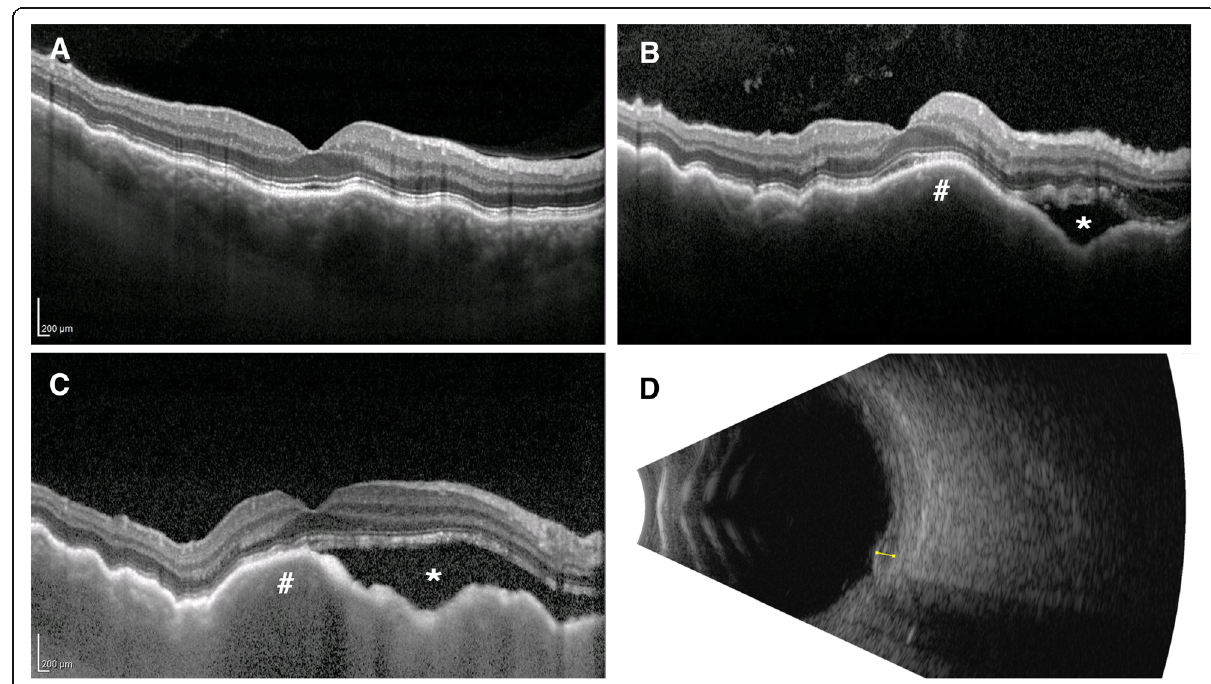
Fig. 1 EDI-OCT of patient prior to treatment initiation. a ) EDI-OCT at initial diagnosis of choroid folds; b ) EDI-OCT following worsening of symptoms 11 months later; c ) EDI-OCT on presentation to ophthalmology oncology clinic; d ) ocular ultrasound with yellow line showing lesion depth of 1.5 mm. EDI-OCT = enhanced depth imaging optical coherence tomography ’ * = subretinal fluid; # = choroidal